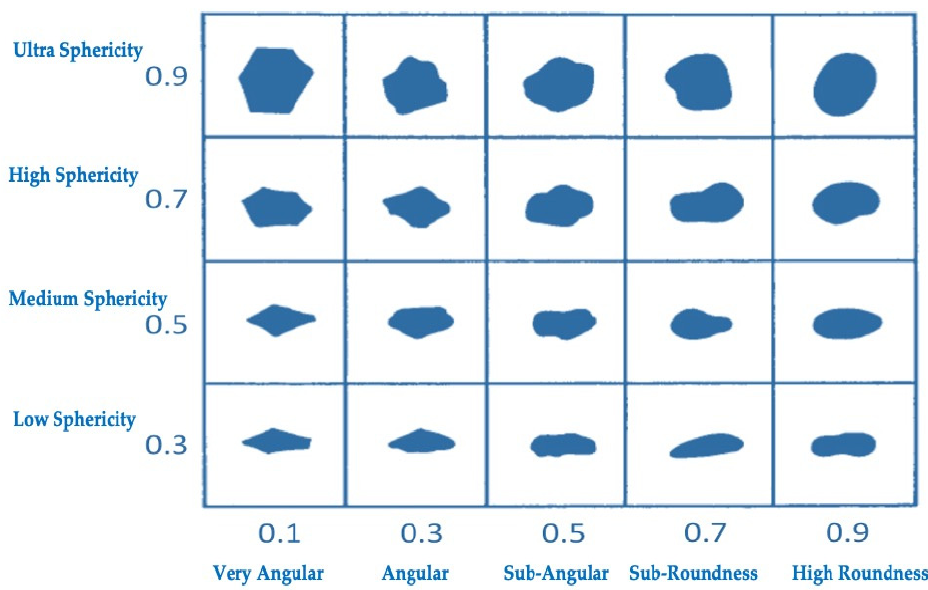
Figure 9. Classification chart based on roundness and sphericity of particles (modified from [40,84,87,88]).